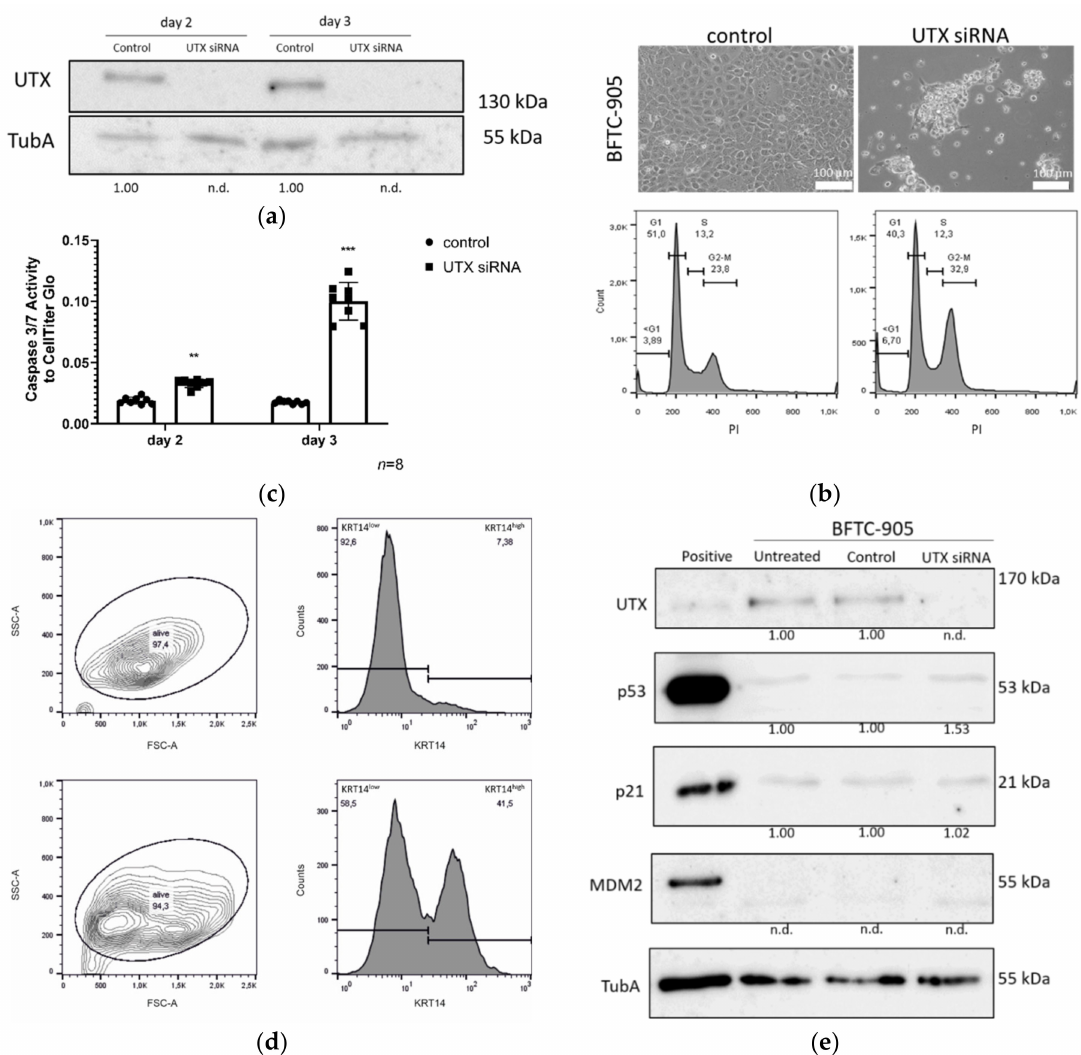
Figure 9. E ff ects of UTX knockdown on BFTC-905 urothelial carcinoma cells. ( a ) E ffi cient knockdown of UTX protein shown by Western blot analysis. ( b ) Changes in morphology, cell numbers and cell cycle profile on day 3 after transfection of UTX-siRNA 01 compared to control siRNA. Note that only a population of small cells normally located in the center of the colonies survives and the cell cycle profile shows increased fractions of cells in the G2 / M and sub-G1 phases. ( c ) Caspase-Glo 3 / 7 activity relative to total viable cells measured by CellTiter-Glo assay 3 days after treatment with control siRNA or UTX-siRNA. ( d ) FACS analysis of cell size and KRT14 expression. Note the shift towards smaller cells in the FSC-A channel and an increased fraction of KRT14 high cells. Number of analyzed experiments n = 3. ( e ) UTX, p53, p21 and MDM2 protein expression in BFTC-905 cells 2 days after transfection with control siRNA or UTX-siRNA. α -Tubulin (TubA) was used as an internal loading control. As a positive control for p53, p21 and MDM2 expression VM-CUB-1 cells were used. Statistics were performed with a one sample t test against a set value of 1 (** p < 0.01; *** p < 0.001). The UTX siRNA knockdown samples at di ff erent time points were compared using an unpaired students t test. Scale 100 µ